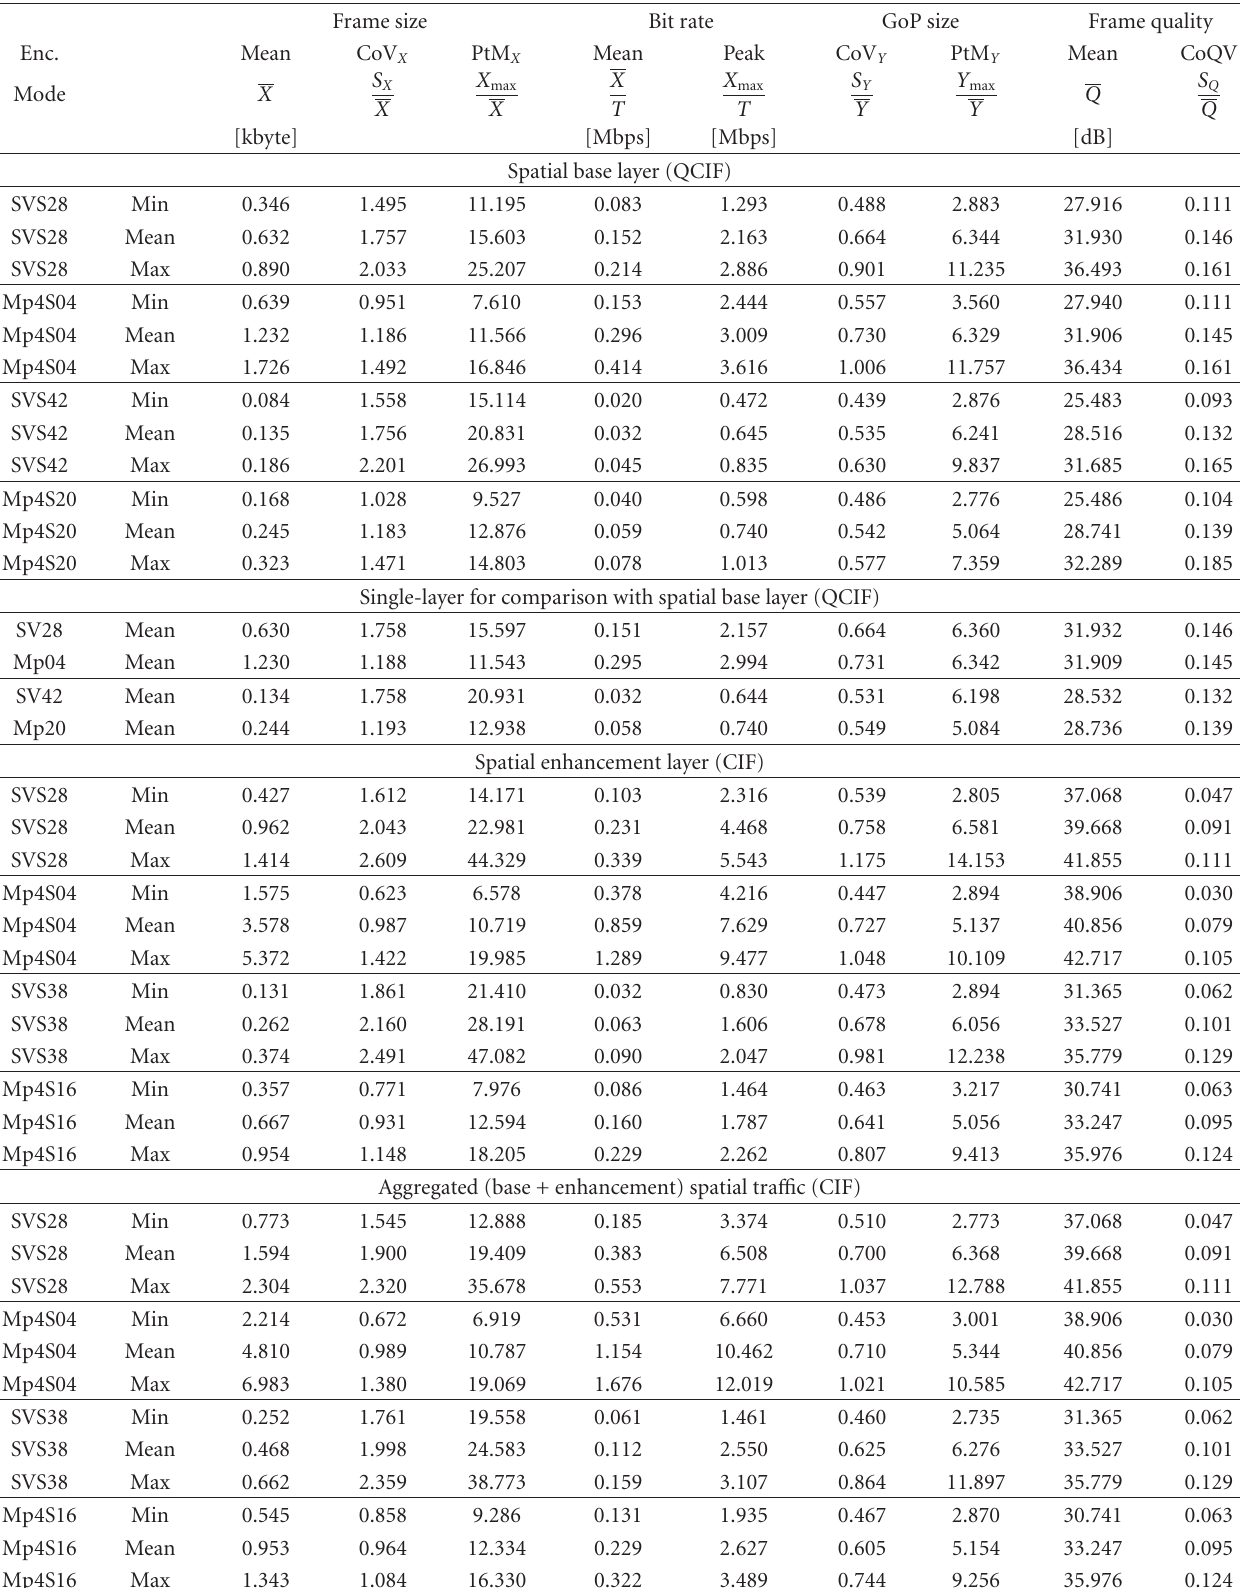
Table 4: Tra ffi c statistics for base (QCIF), and enhancement (CIF) layers, and aggregated tra ffi c of spatial scalability encodings using H.264 SVC and MPEG-4 Part 2 for selected quantization scales. Frame size Bit rate GoP size Frame